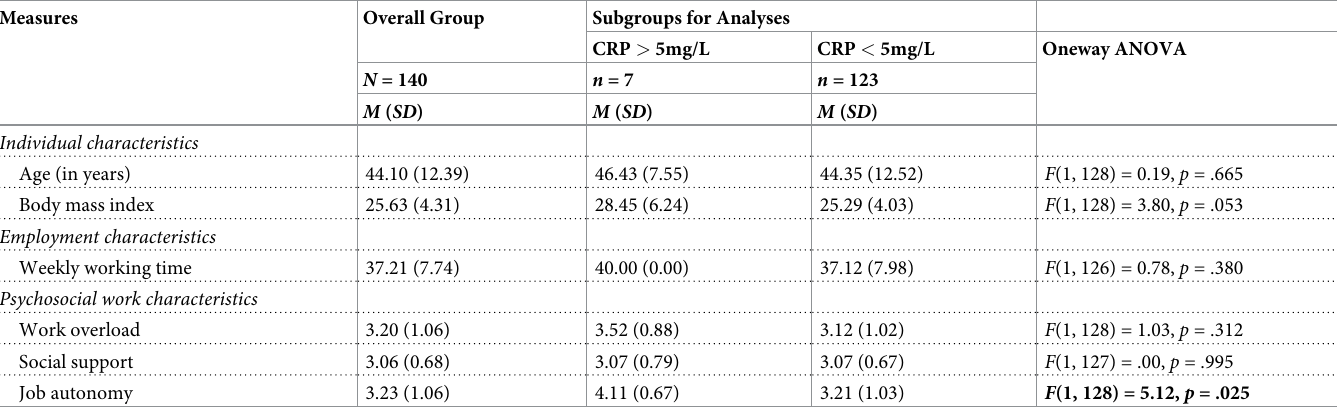
Table 1. Care professionals’ individual, employment, and psychosocial work characteristics (for overall group and subgroups based on CRP cut-off > 5mg/L).